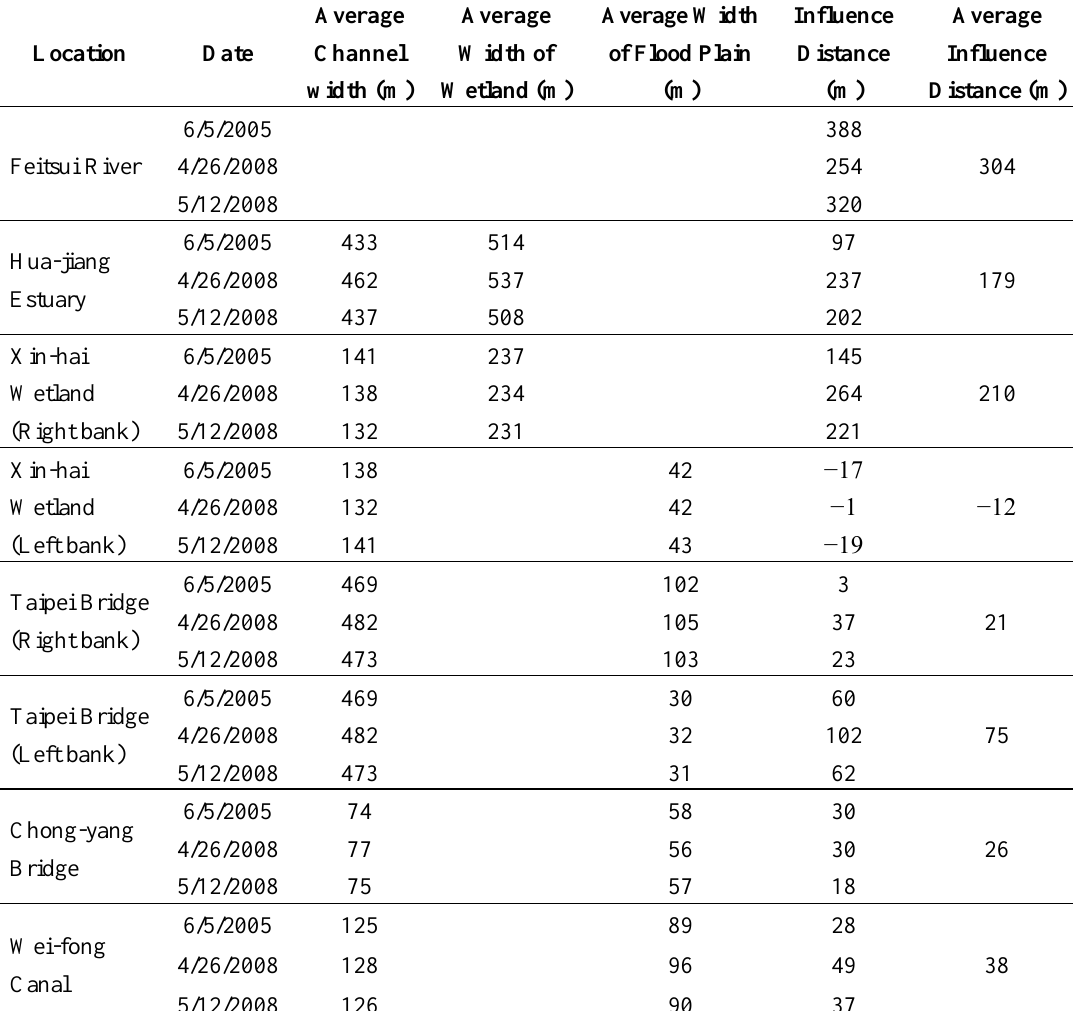
Table 2. Summary of area